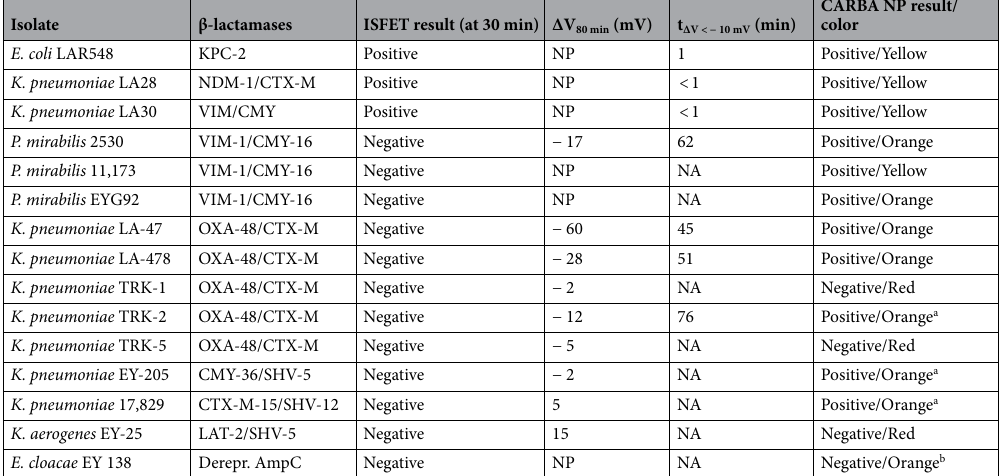
Table 4. Assessment of ISFET false negative results through prolonged measurements and comparisons with RAPIDEC CARBA NP (ISFET true positives and true negatives included). NP: Not performed. NA: Not applicable as the − 10 mV threshold had not been reached. a Result became positive after 2 h of incubation at 37 °C. b The control well lacking imipenem yielded also an orange color.